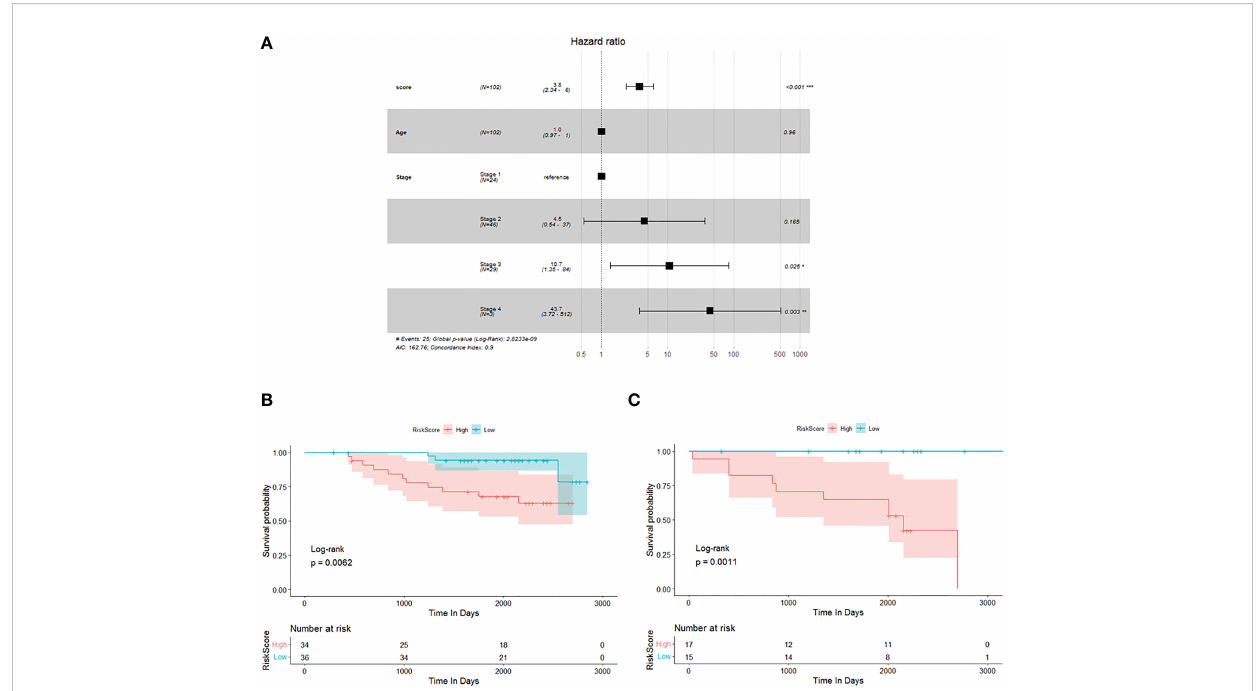
FIGURE 2 Veri fi cation of potential TME prognostic genes and risk score using testing database. (A) Multivariate Cox regression analysis forest plot. (B, C) The Kaplan – Meier survival curve of breast cancer patients<60 years old and ≥ 60 years old,